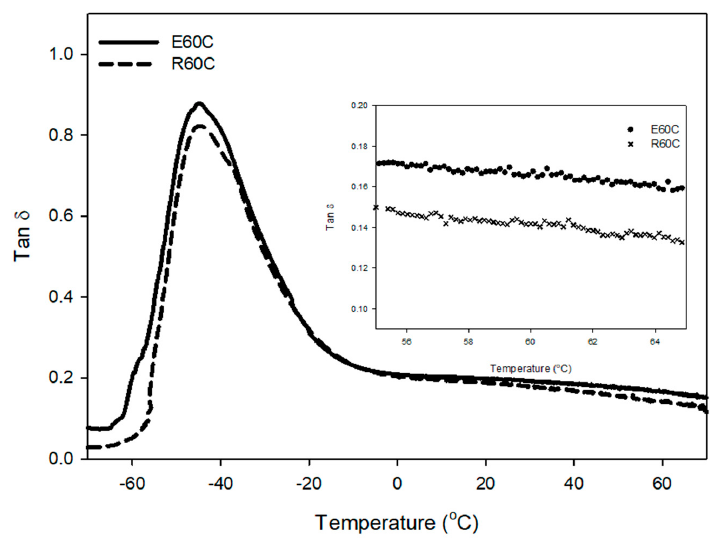
Figure 8. Temperature-dependent tan δ of vulcanizates of emulsion styrene butadiene rubber (ESBR) and reversible addition-fragmentation radical transfer (RAFT) ESBR carbon black-filled compounds. Table 7. Viscoelastic properties of vulcanizates of emulsion styrene butadiene rubber (ESBR) and reversible addition-fragmentation radical transfer (RAFT) ESBR carbon black-filled compounds. ESBR RAFT ESBR T g ( ◦